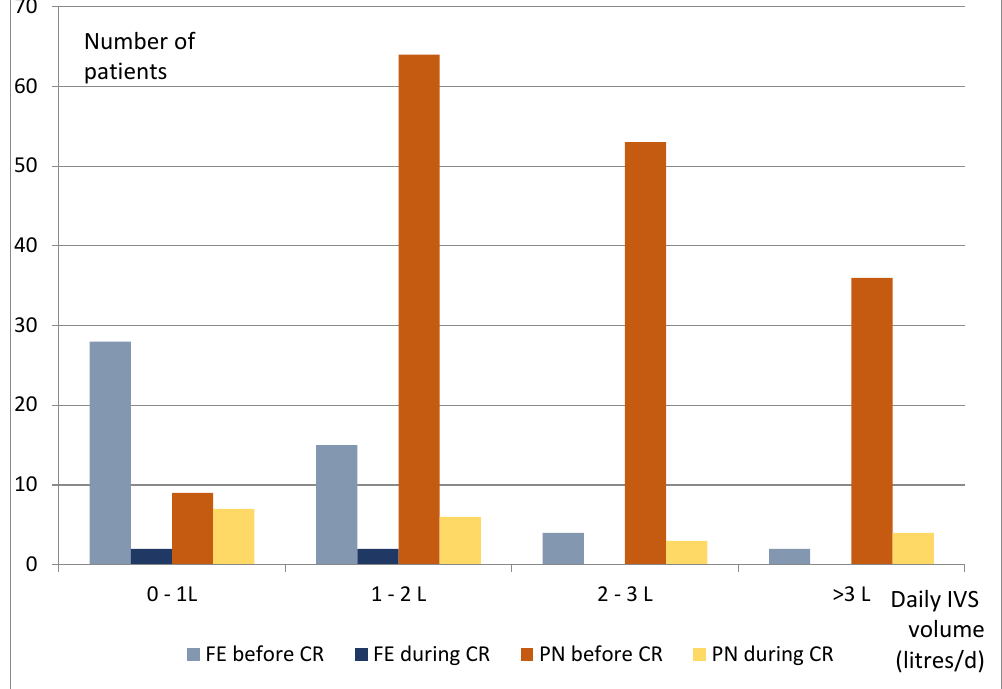
Figure 4. Daily volume of the intravenous supplementations (IVS) before and during chyme reinfusion ( n = 211 patients), in liters (L). CR, chyme reinfusion; FE, fluids and electrolytes; PN, parenteral nutrition.